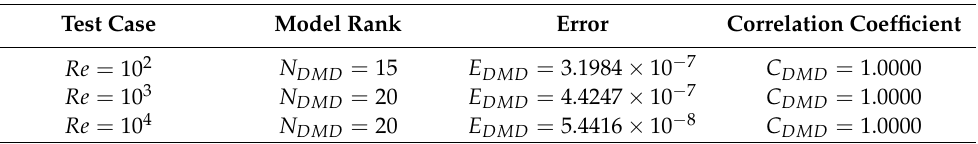
Table 1. Comparison of the numerical results returned by the randomized dynamic mode decompo- sition algorithm. A total of 300 data snapshots have been processed.